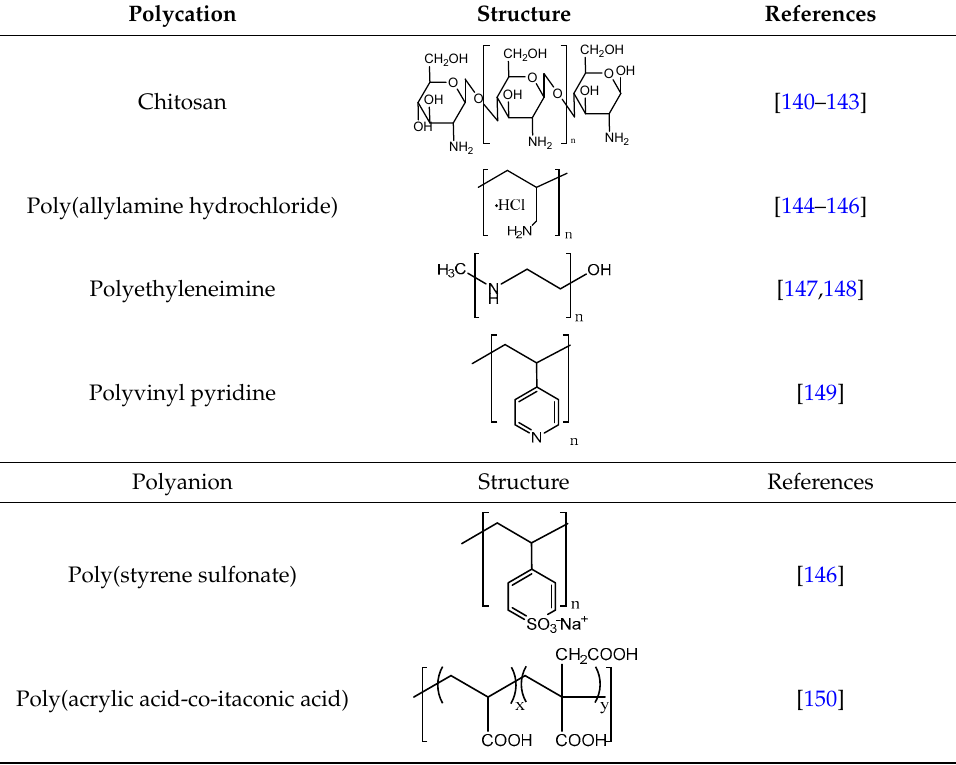
Table 2. Polyelectrolytes most commonly used in the design of pH-responsive gates through electrostatic interactions between them or with the nanocarrier.